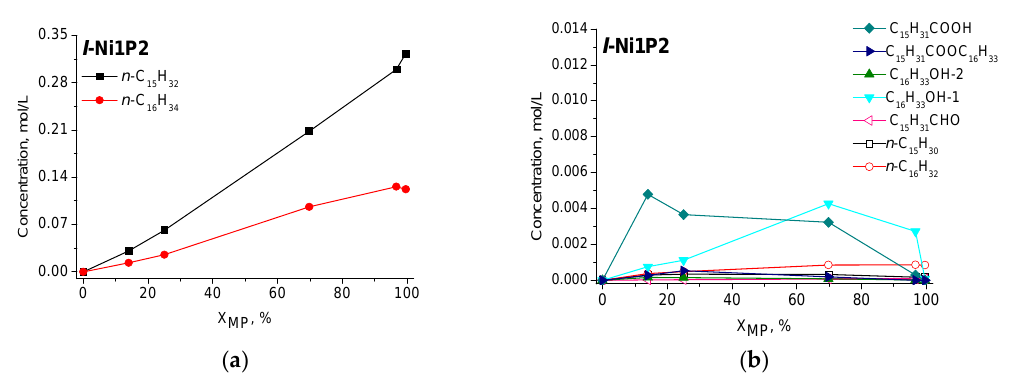
Figure 8. Concentration profiles of the liquid ‐ phase components during methyl palmitate HDO over l ‐ Ni1P2 catalyst: ( a ) the main products—C 15 and C 16 hydrocarbons; ( b ) the observed intermediates.